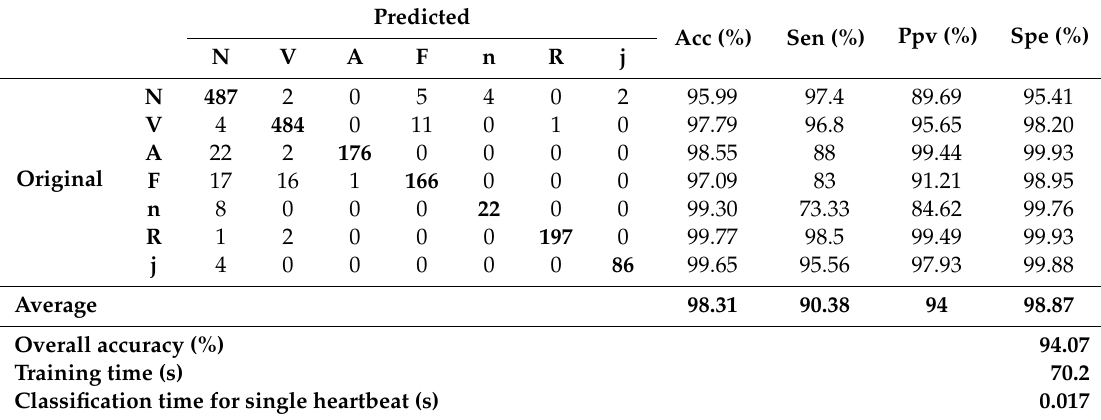
Table 13. Confusion matrix obtained using II and V5 leads across 5 folds.